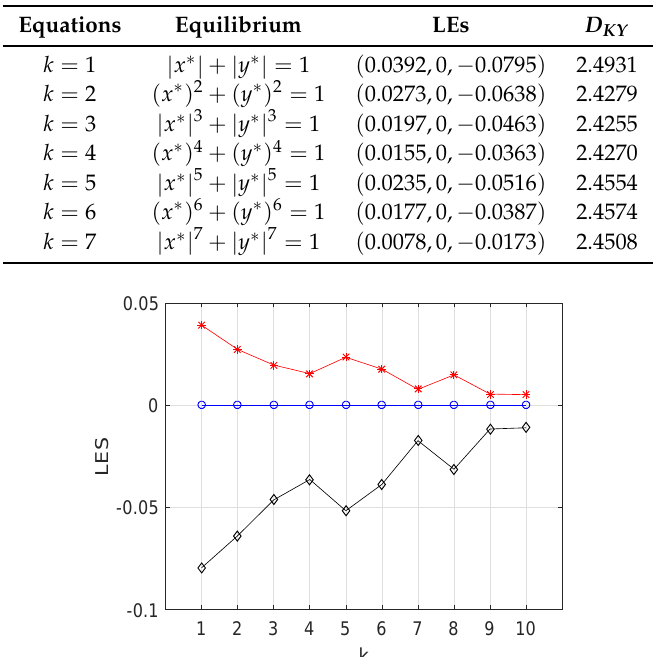
Table 1. Lyapunov exponents of the system (3) for the value of k from 1 to 7.